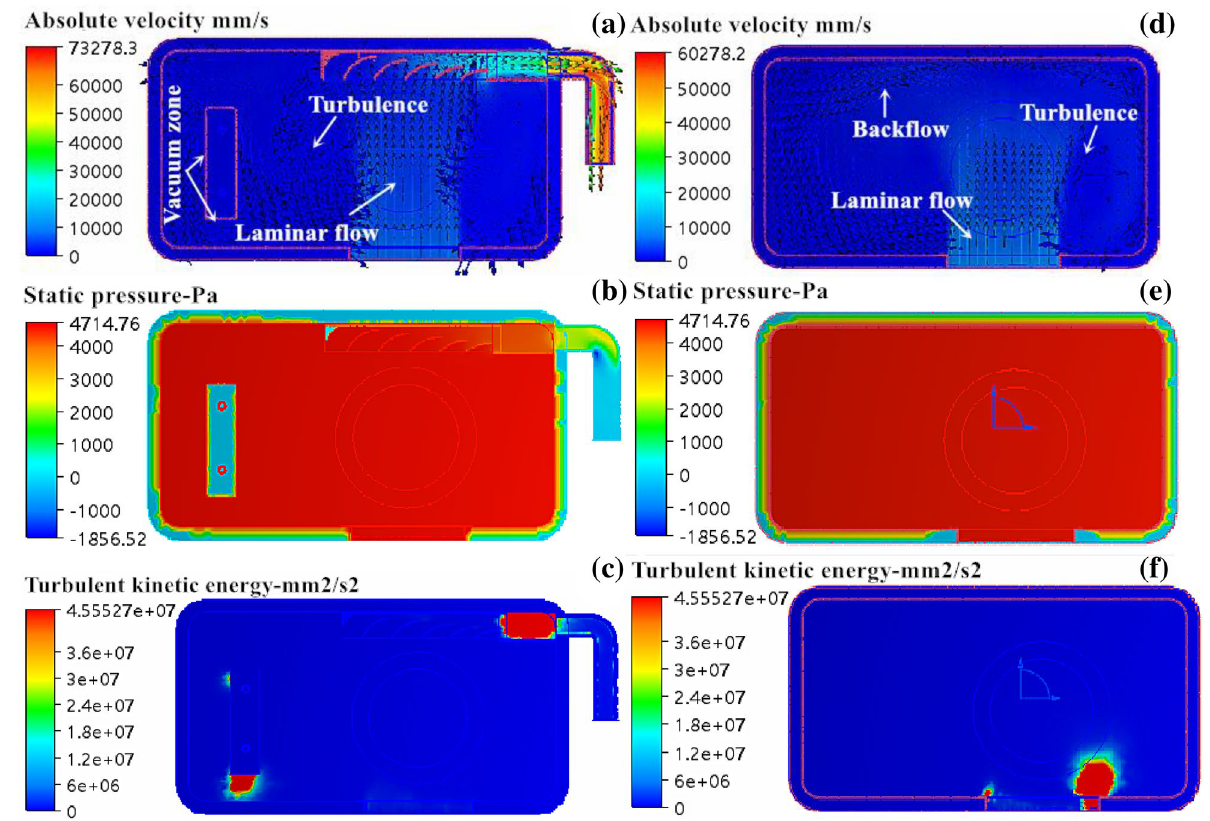
Figure 7. Simulation results of mold flow in forming cavity: ( a ) and ( d ) are velocity distribution diagrams; ( b ) and ( e ) pressure profiles; ( c ) and ( f ) turbulence original forming cavity, and no significant change was found. In Fig. 7f, the turbulence distribution of nitrogen entering the forming cavity from the upper inlet end is shown. The turbulence was mainly concentrated at both ends of the inlet, and no obvious turbulence was found at other locations. In addition, the distribution area was smaller and the intensity was much less than those of the orbital forming cavity, indicating that the fluid distribu- tion in the forming cavity was effectively improved by changing the guide plate from circular hole to sheet shape. In general, the fluid distribution in the forming cavity was obviously improved using Design 1, but there were still some defects. For example, the turbulence at the lower end of the forming cavity and the turbulence at both ends of the upper inlet of the forming cavity were still large. The large turbulence distribution intensity levels and areas at the above two locations may be caused by differences in the flow velocities at the inlet of the upper and lower ends of the forming cavity and the absence of a chamfer at both ends of the guide plate. Thus, we further optimized the inlet mode of the forming cavity on the basis of these two points.